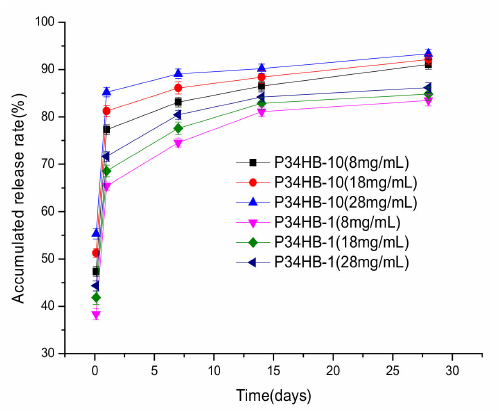
Figure 2. Drug release profiles of coatings with different P34HB